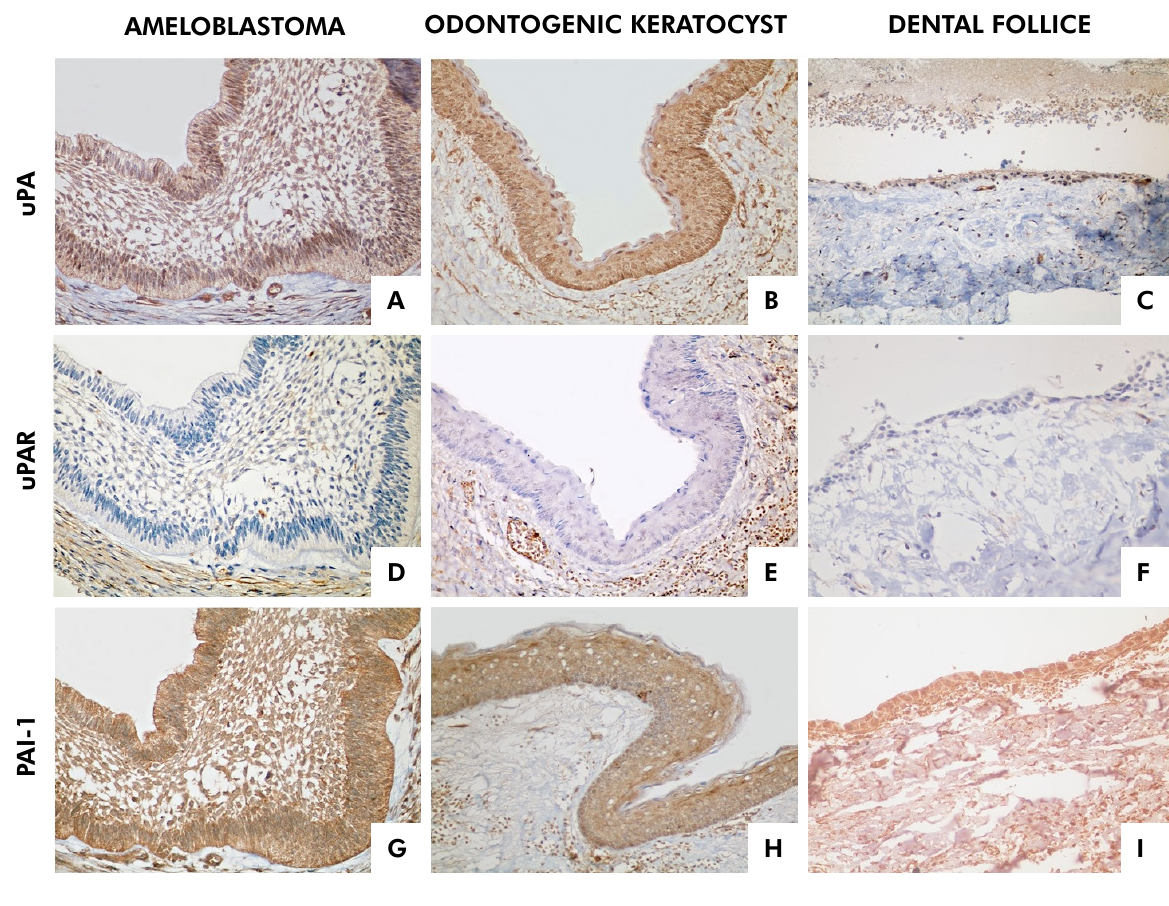
Figure 1. Immunoexpression in odontogenic epithelium. uPA: (A) indistinct staining pattern in AMB; (B) uniform staining in OKC; (C) reduced enamel epithelium of DF. uPAR: (D) low percentage of stained cells in AMB; (E) absence of immunostaining in the cystic epithelium of OKC; (F) absence of immunostaining in DF. PAI-1: (G) indistinct staining pattern in AMB; (H) uniform staining in OKC and (I) in reduced enamel epithelium of DF. Images captured at 400x magnification.